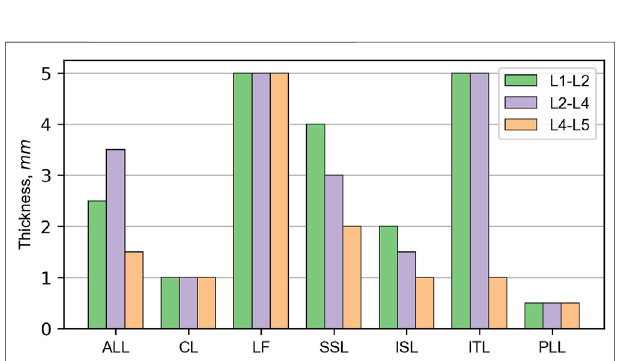
FIGURE 3 | Thickness of ligaments in the lumbar spine